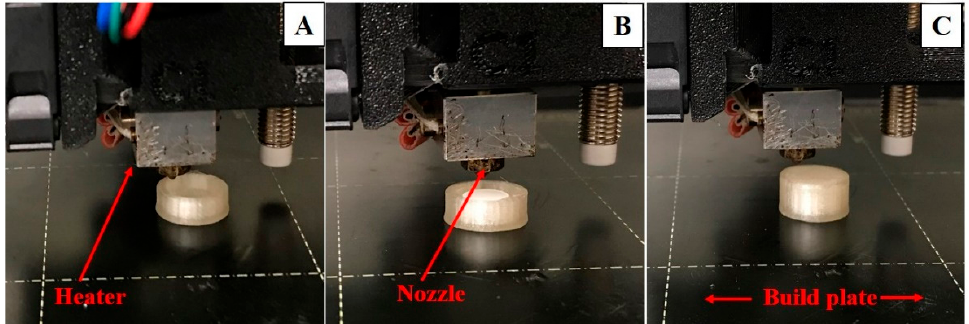
Figure 4. Eighty percent of the printed empty shell of a floating tablet ( A ), placement of a compressed tablet in the shell ( B ), and a completely sealed floating tablet ( C ).